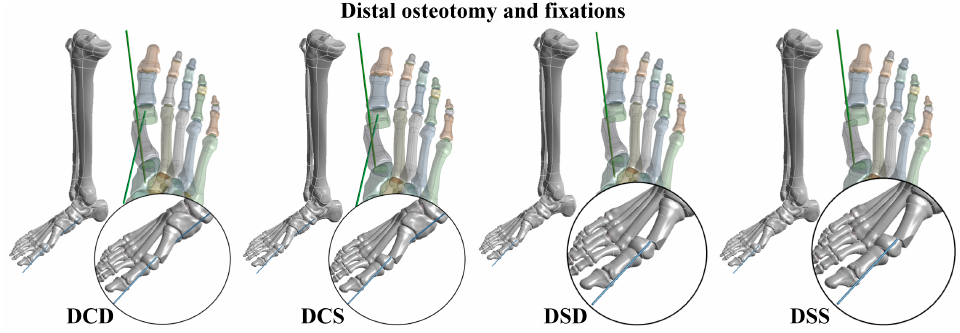
Figure 3. Four types of distal metatarsal osteotomy (DMO) and Kirschner wire fi xation strategies.